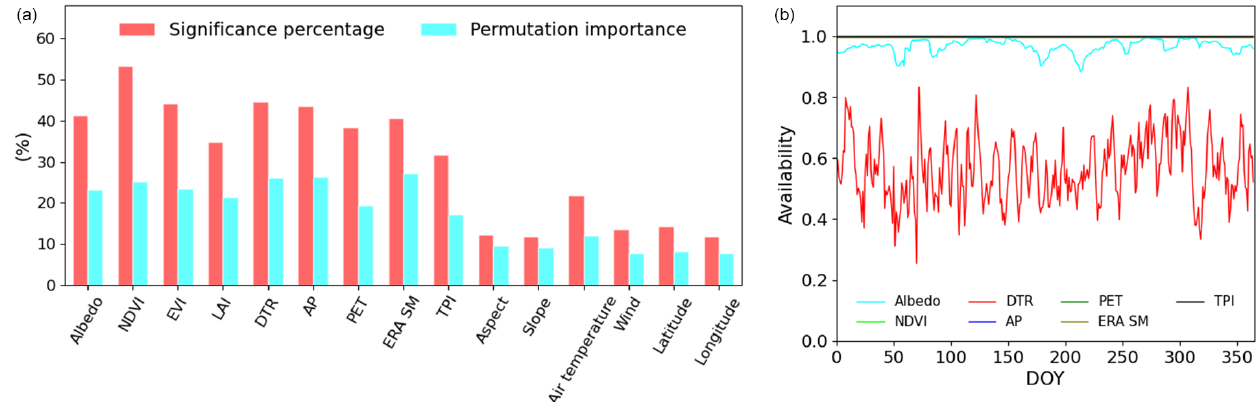
Figure 3. Correlation and availability of the dataset used. (a) Significance percentage and permutation importance of the selected variables in correlation with CCI SM. (b) Availability of the selected